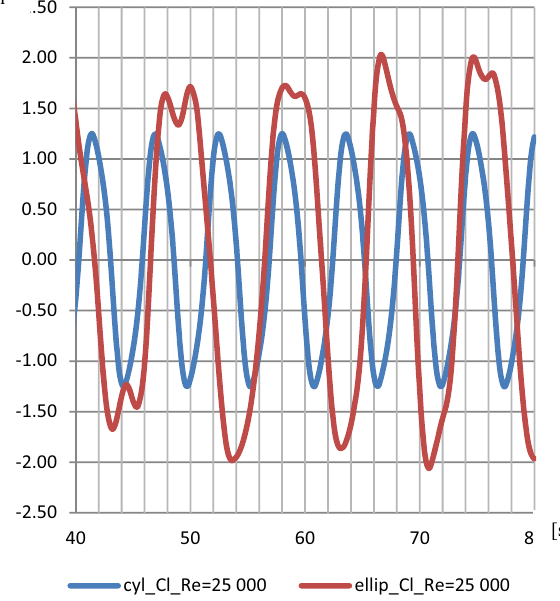
Fig.11 Flow time of lift coefficient Cl, for circle and ellipse sections, Re=25 000